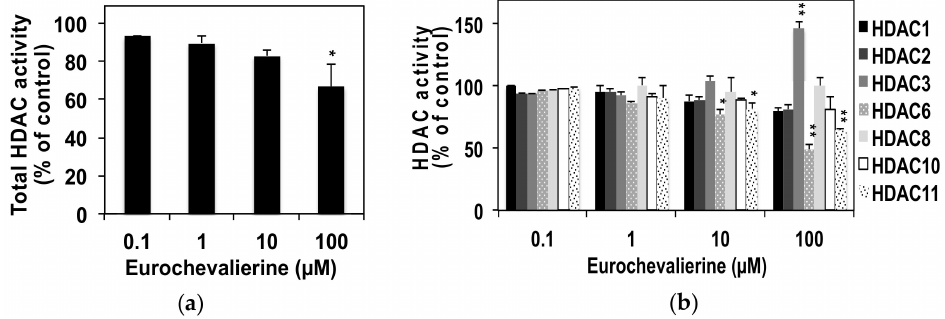
Figure 3. Eurochevalierine displays a moderate effect on in vitro non-sirtuin HDAC activities. ( a ) In vitro total HDAC activity was evaluated using K-562 nuclear extracts in the presence of various concentrations of eurochevalierine. ( b ) Selective in vitro HDAC activity assays were carried out using selected recombinant HDAC proteins in the presence of various concentrations of eurochevalierine. Results are reported as percent of DMSO vehicle control and expressed as the mean ± SD of three independent experiments. * and ** indicate p < 0.05 and p < 0.01 versus untreated cells, respectively.